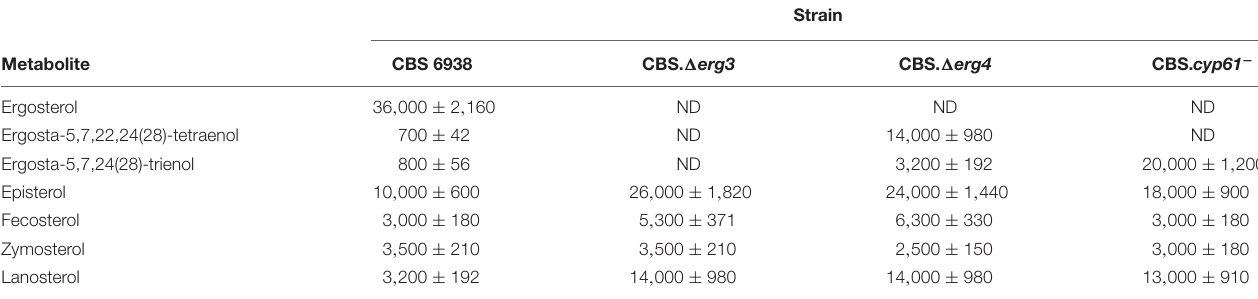
TABLE 2 | Composition (in relative abundance) of sterols of the mutant and parental strains of X. dendrorhous analyzed by HPLC/MS.